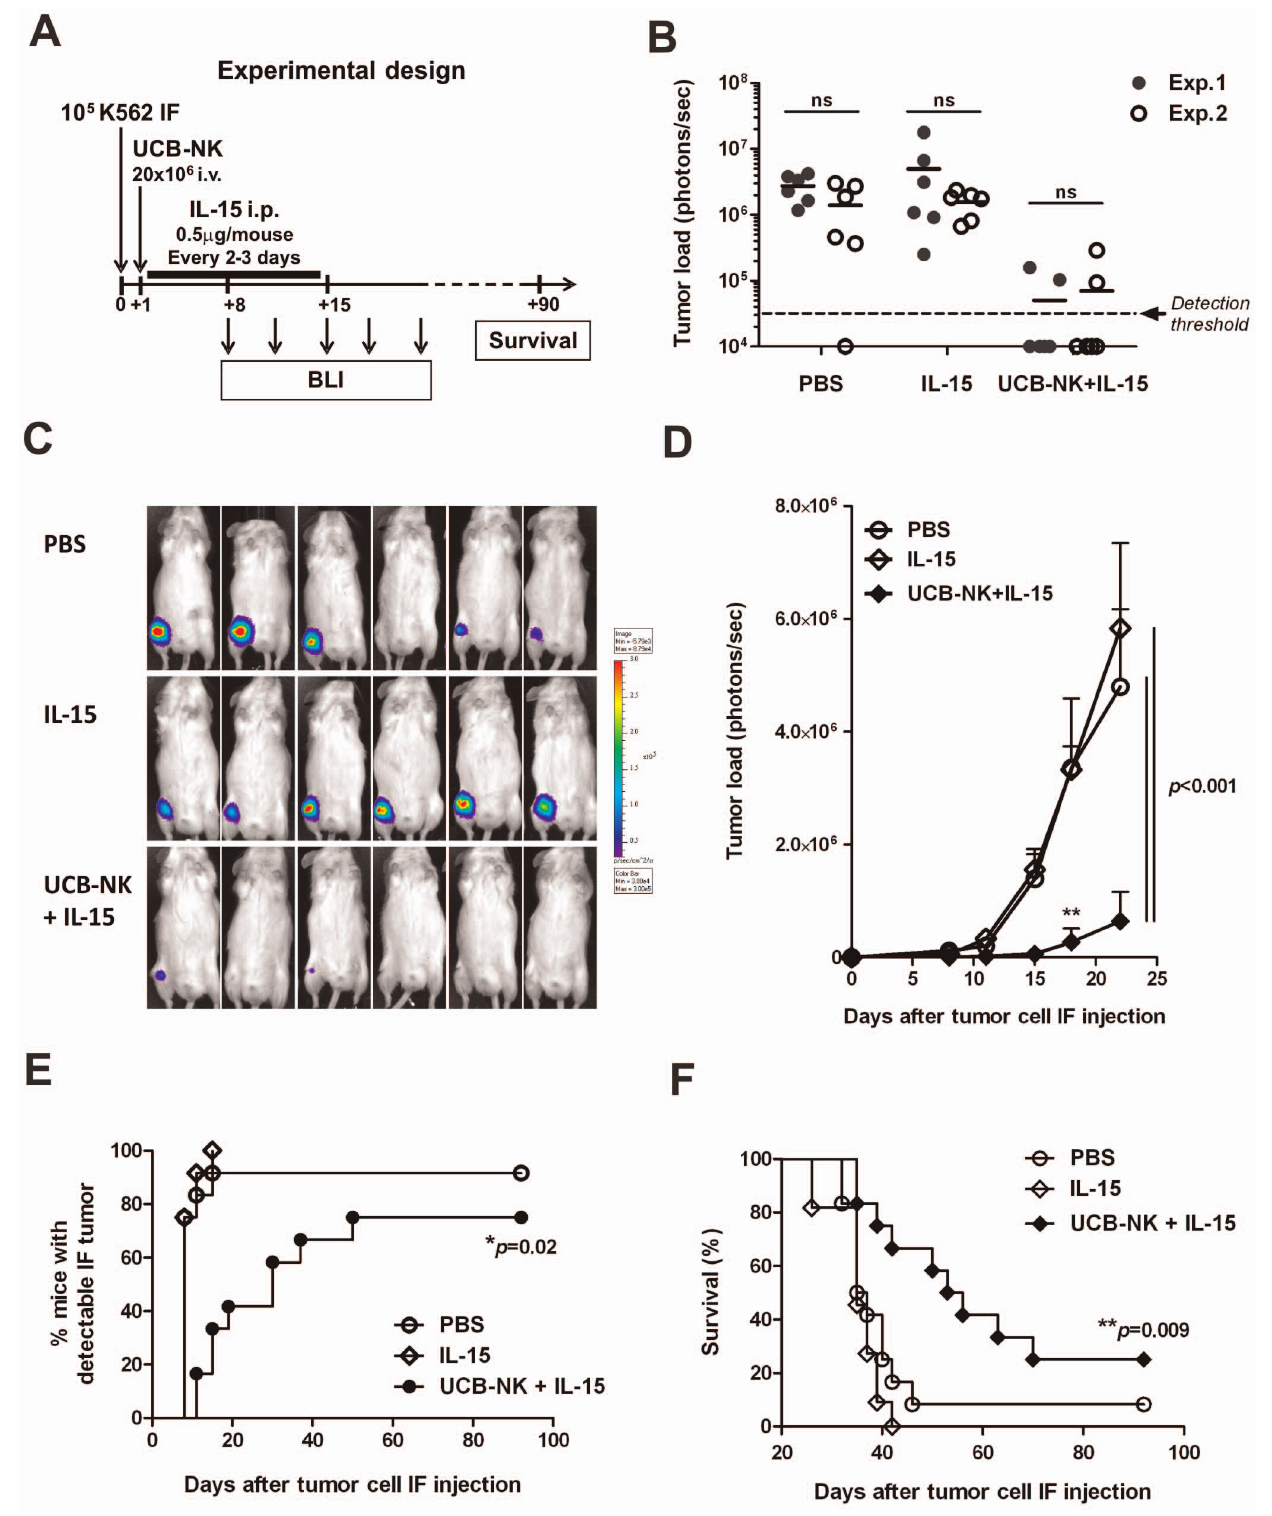
Figure 6. A single infusion of UCB-NK cells inhibits growth of BM-residing human leukemia cells. The potential of UCB-NK cells to attack human leukemia in vivo was evaluated in NSG mice bearing K562 intra-femoral ( i.f .) tumors. (A) Experimental study design: adult NSG mice were injected in their right femur with 10 5 K562.LucGFP cells. The day after, mice were treated with 20 6 10 6 UCB-NK cells i.v. in combination with IL-15 administration (0.5 m g/mouse i.p. every 2–3 days for 14 days), or received PBS or IL-15 alone as control (n=6 per group). Tumor load was monitored by BLI from day 8 after K562.LucGFP cell inoculation and next every 3–4 days for 2 weeks. At later time points, only mice with undetectable tumor load were imaged. (B) Two independent anti-leukemic studies were performed with similar outcomes. Tumor load per mouse measured at day 15